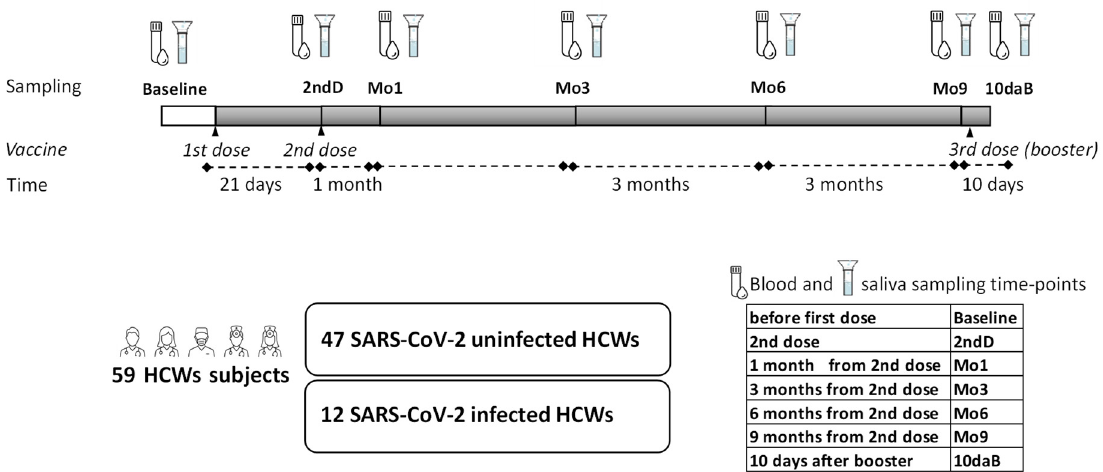
Figure 1. Overview of the study workflow. The schedule for BNT162b2 vaccine administration, the timing of blood and saliva sampling, and a scheme of groups of healthcare workers (HCWs) enrolled for this study.